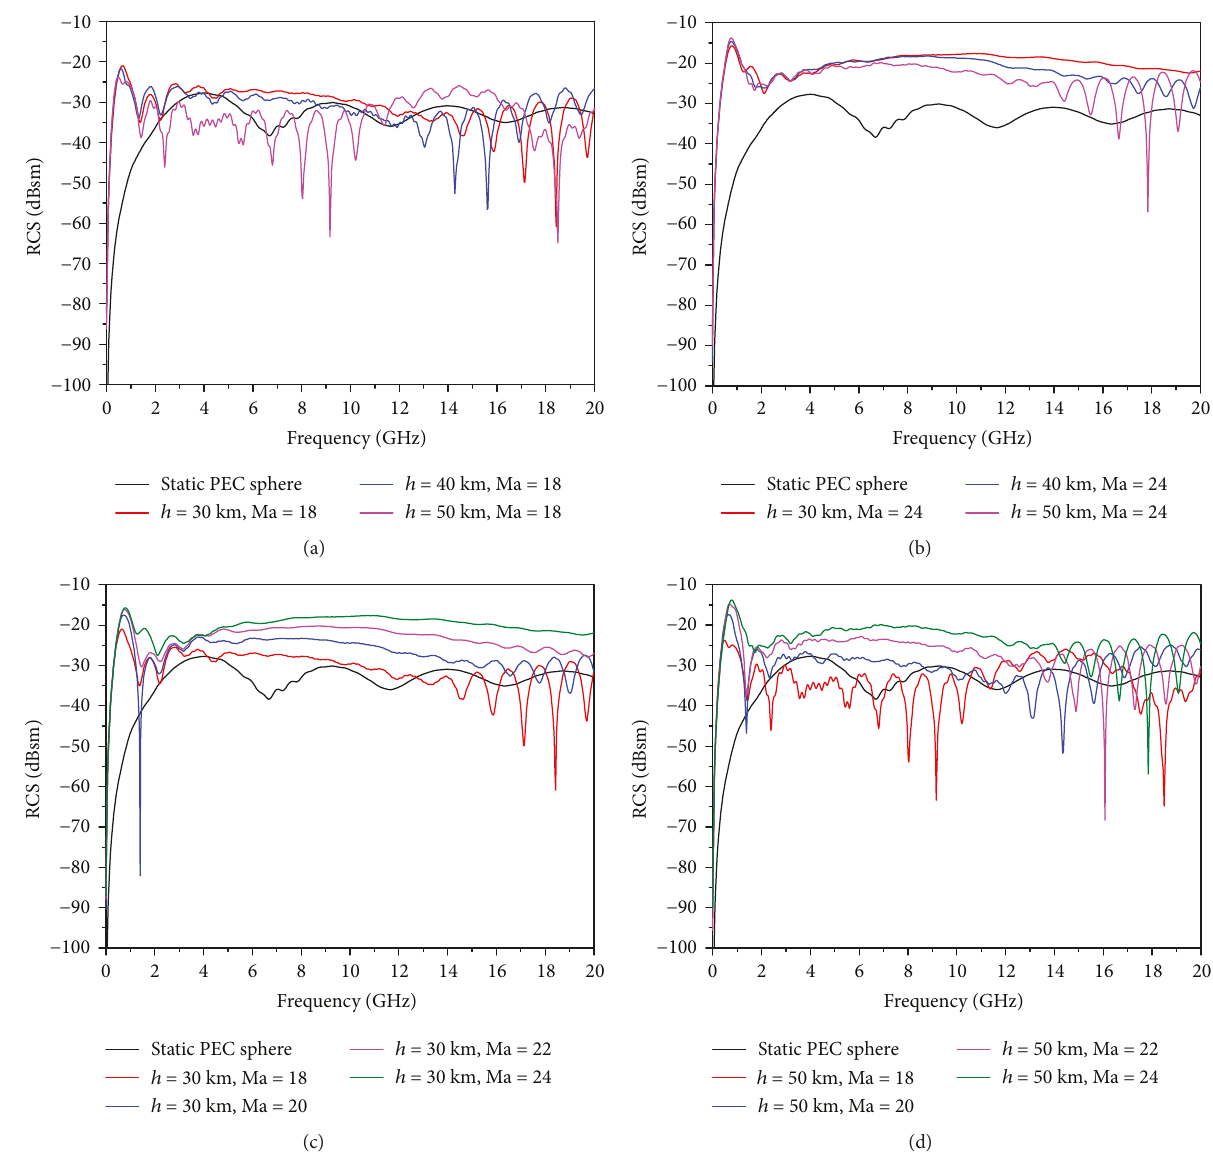
Figure 9: Distributions of backward RCS against frequency for a hypersonic sphere enveloped by a plasma fl ow illuminated by a polarized plane wave with incident angles ( θ = 90 0 ∘ , φ = 180 0 ∘ ). HH RCS components are plotted for di ff erent fl ight conditions. (a) Di ff erent heights, Ma = 18 ; (b) di ff erent heights, Ma = 24 ; (c) h = 30 km, di ff erent velocities; (d) h = 50 km, di ff erent